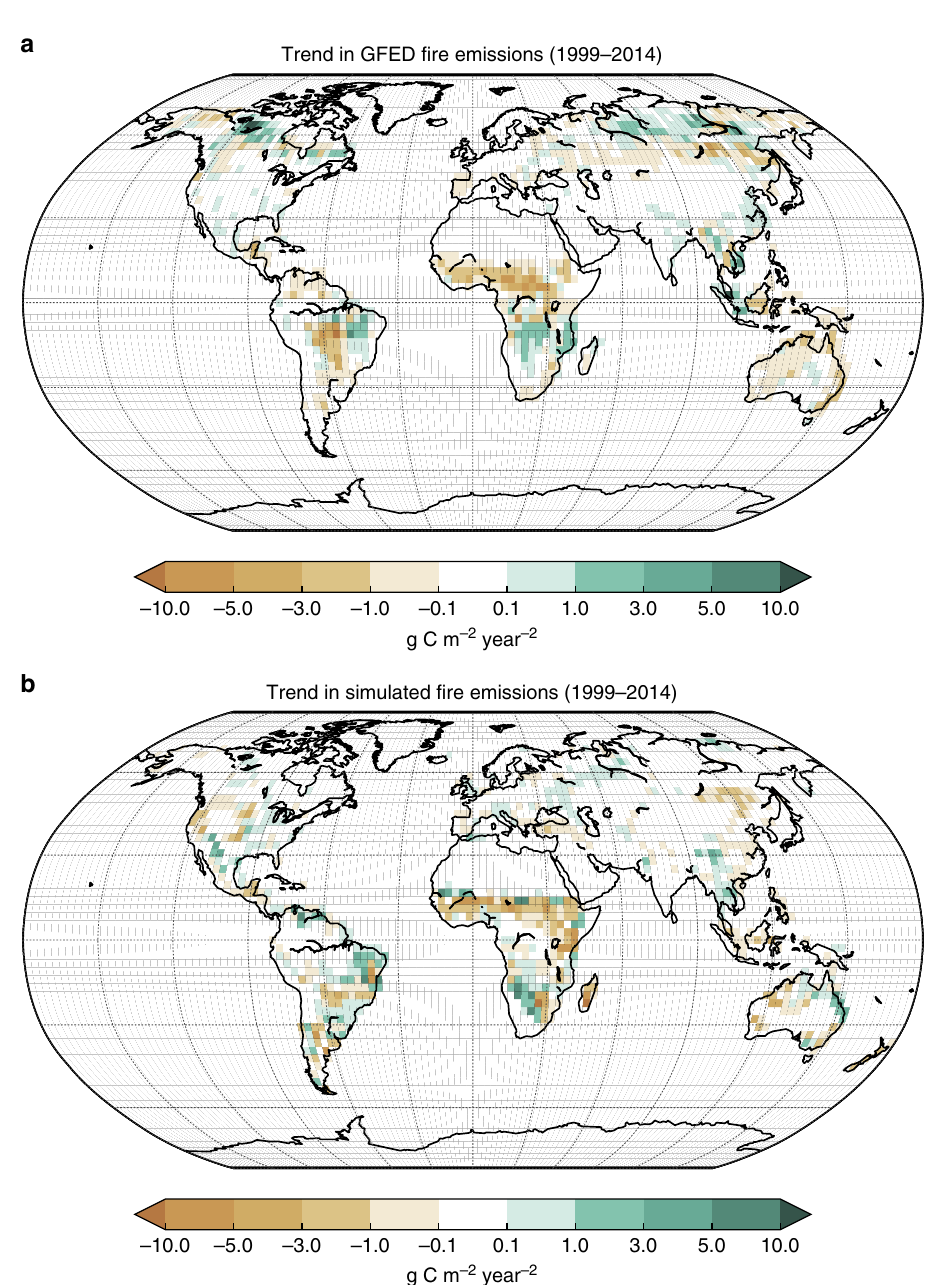
Fig. 3 Comparison of simulated and observed geographical distribution of trend in fi re emissions for the 1999 – 2014 period. a shows the estimates based on fi re emissions from the GFED4.1s 14,15 data set and b shows the trend based on the results from historical simulation with all